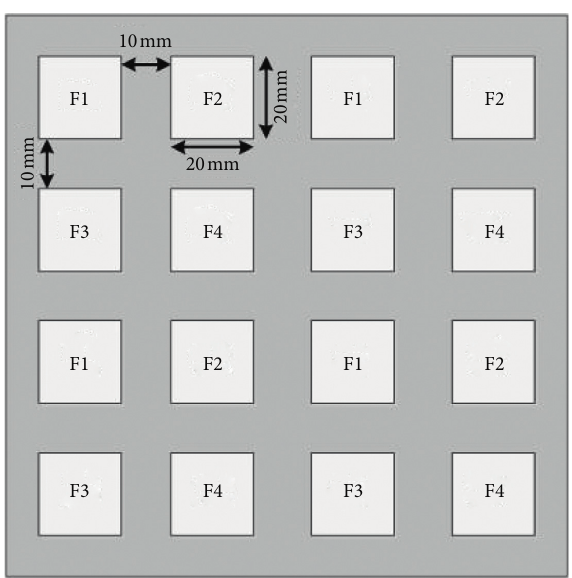
Figure 2: The schematic illustration of the reused frequencies for the proposed cellular sixteen-chip system. For example, the wireless nodes in the first chip communicate together only at the frequency band shown by